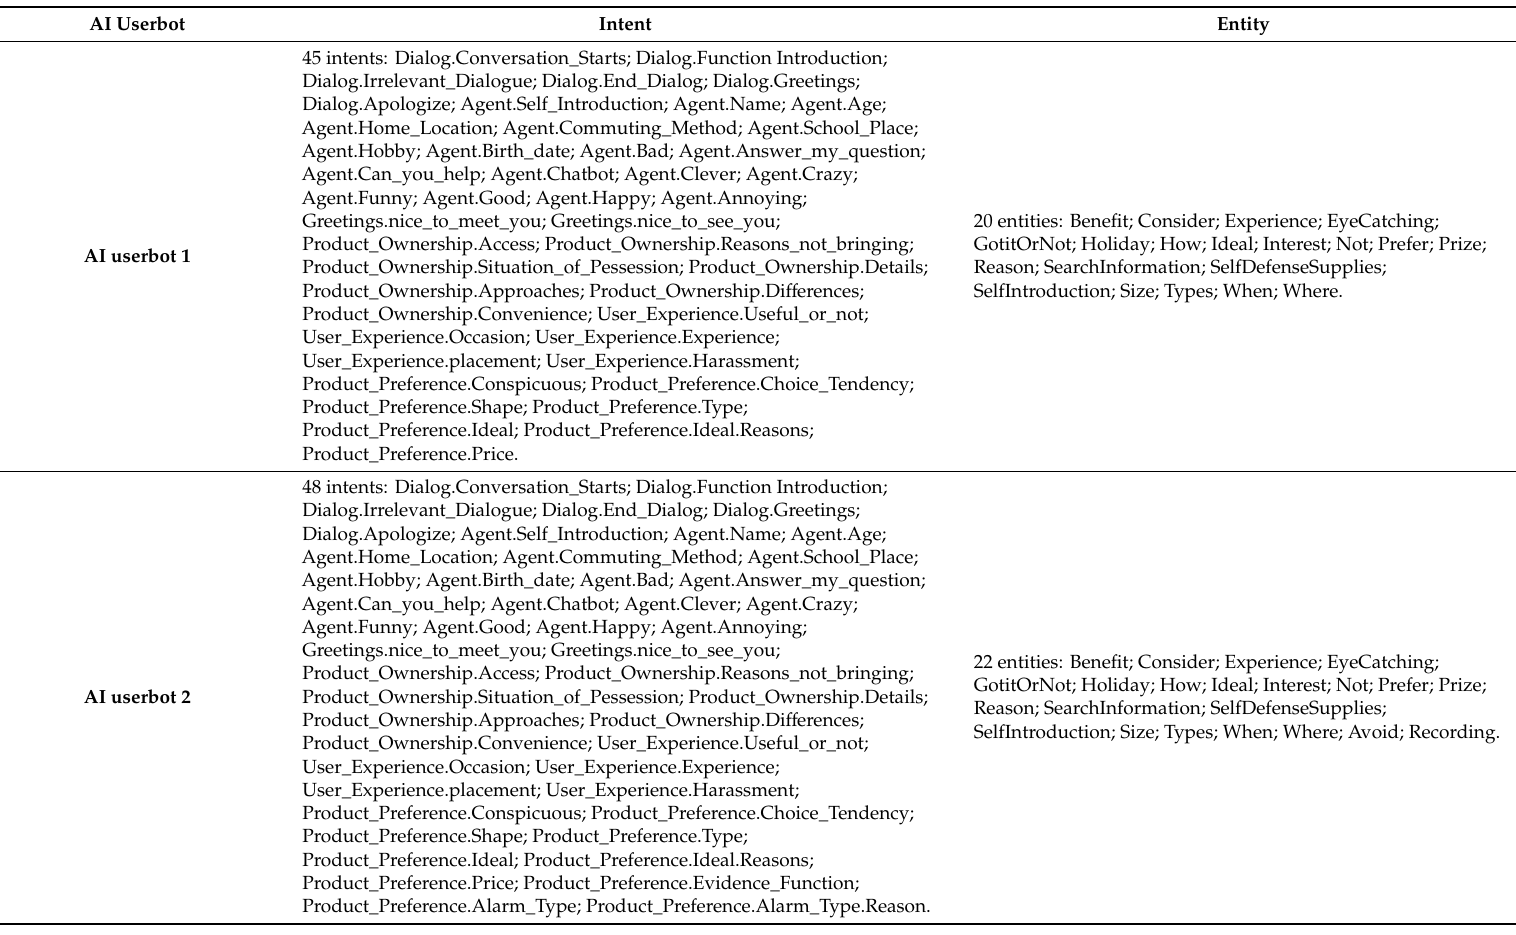
Table A1. List of intents and entities which was built with Dialogflow for three AI